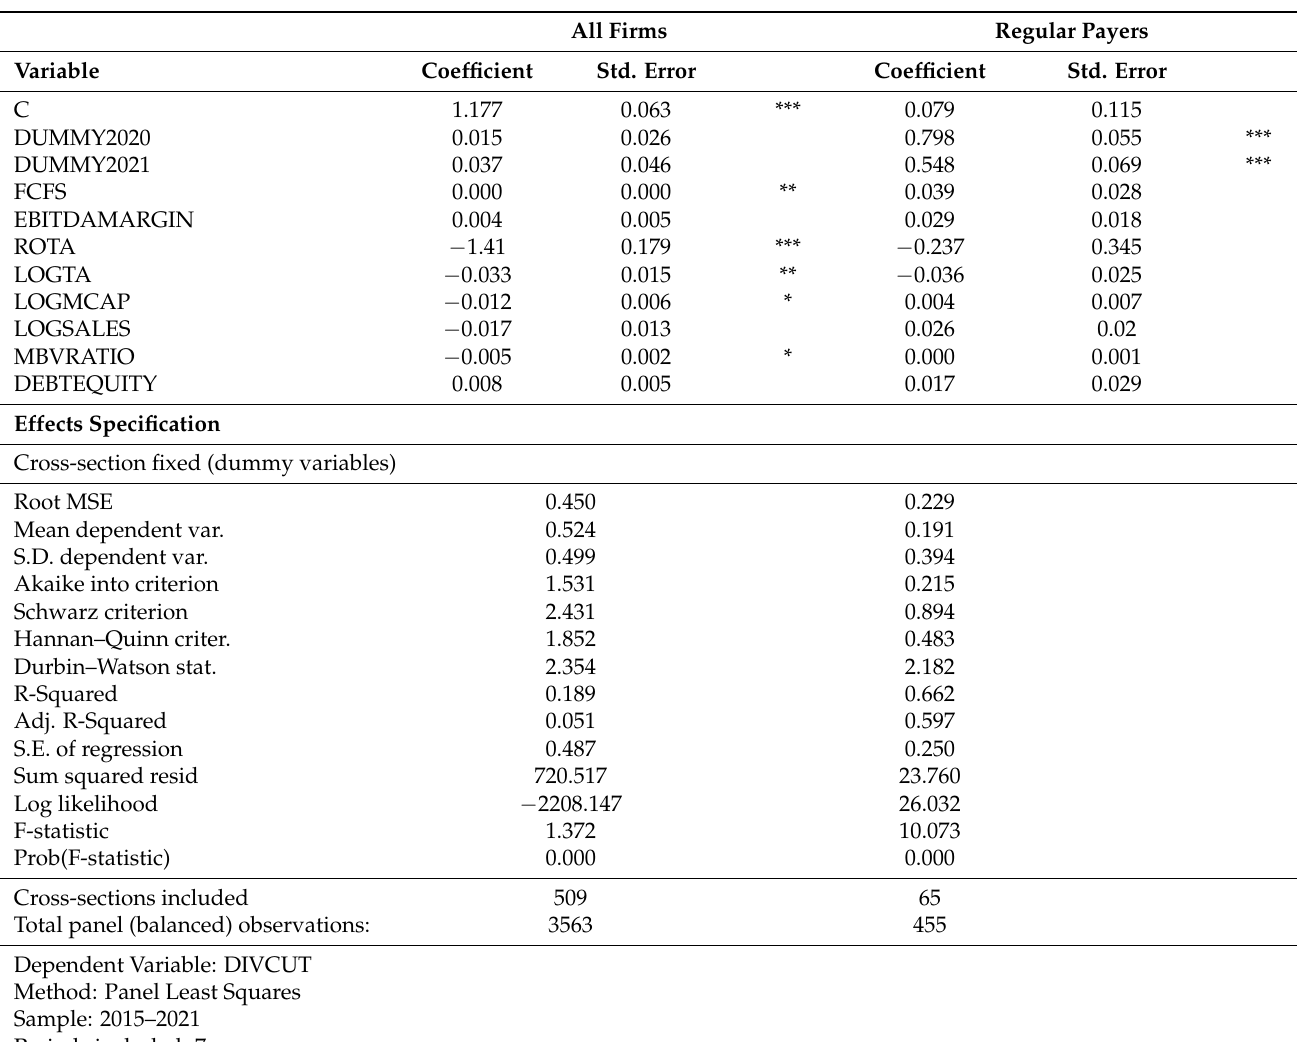
Table 9. Predictors estimates for dividend